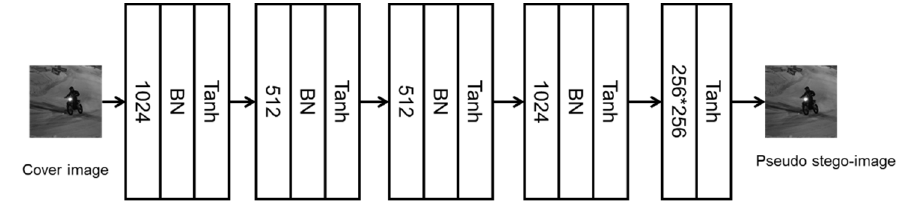
Figure 2. Structure of the fully connected generator.